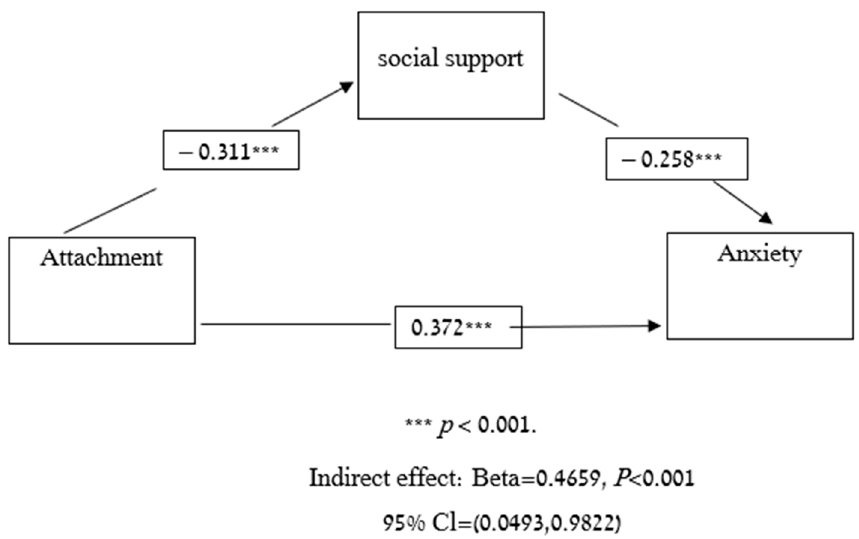
Figure 2. Mediation model-attachment, social support and